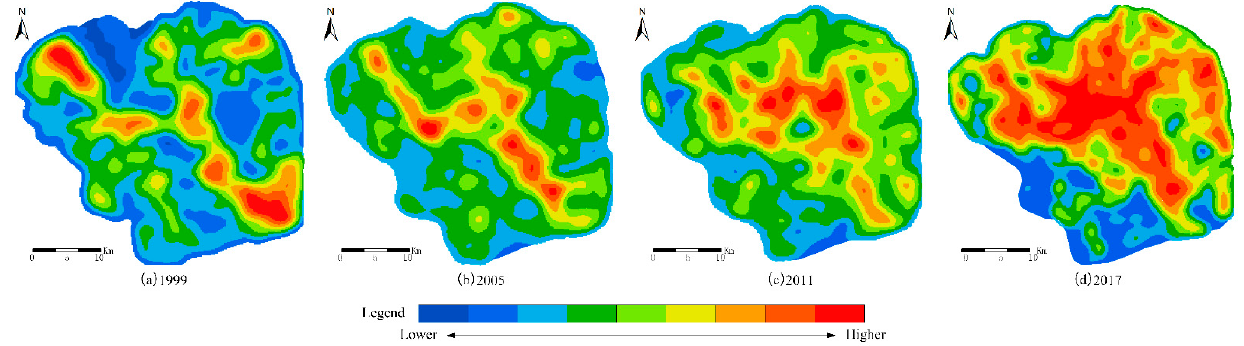
Figure 5. The spatial correlation of urban morphological resilience of Mianyang. Table 5. The CCD between urban growth and urban morphology resilience of